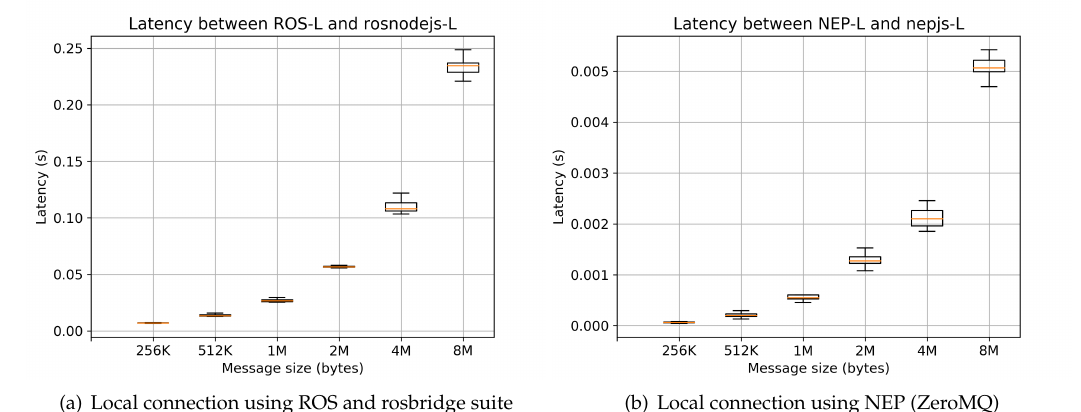
Figure 10. Latency results on scenario L-local; comparisons between NEP and ROS-rosbridge using nodes written in Python 2 and Node.js executed in the same